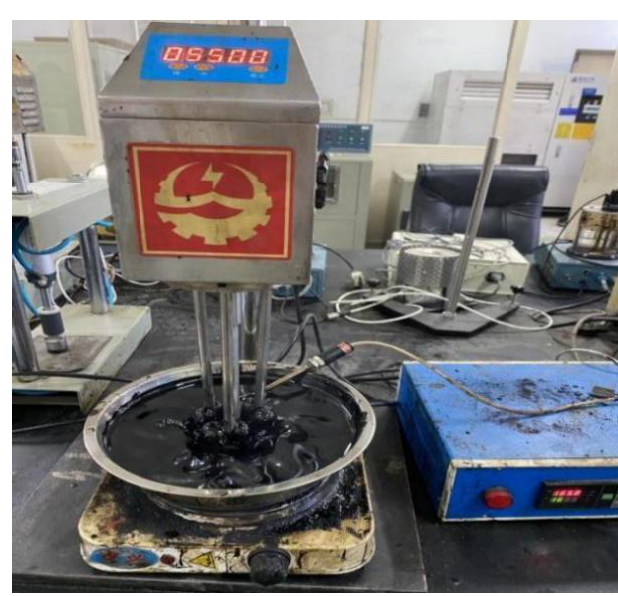
Figure 10. Graphene dispersion process. The microstructure of asphalt after high-speed shear dispersion was analyzed by scanning electron microscopy, as shown in Figure 11.